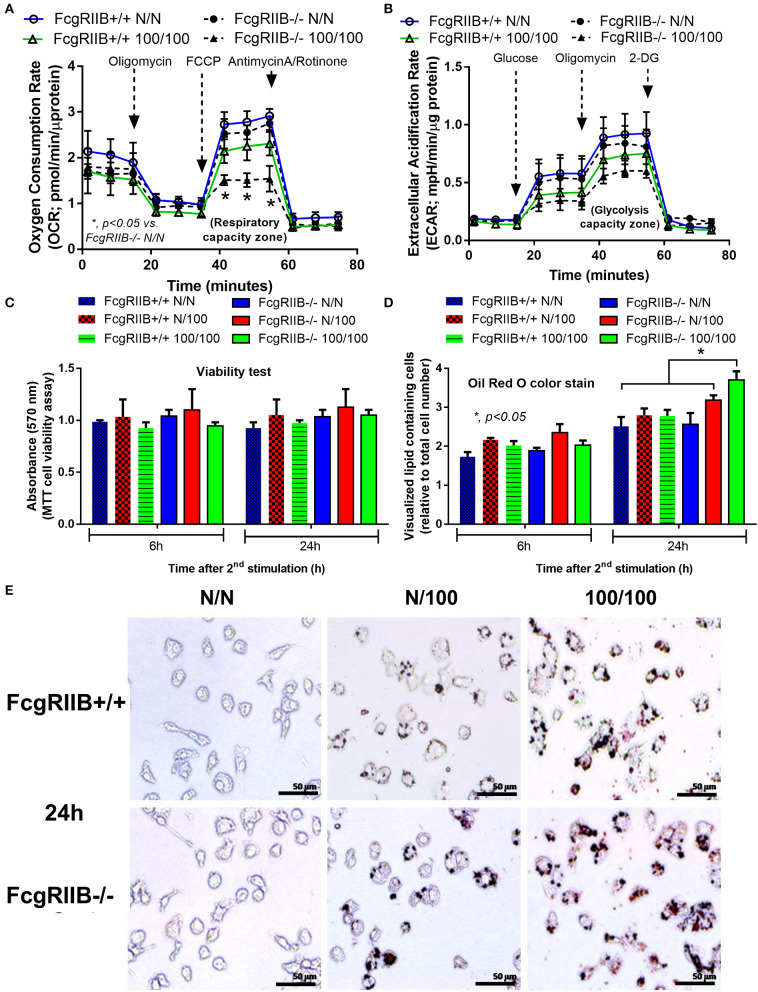
Extracellular flux analysis pattern of macrophages with LPS-tolerance (100/100) or culture media control (N/N) in FcgRIIB–/– and wild-type (FcgRIIB+/+) groups as evaluated by oxygen consumption rate of mitochondrial stress test for mitochondrial pathway analysis (A) and extracellular acidification rate of glucose stress test for glycolysis pathway analysis (B) at 6 h after the second dose of LPS or control culture media are demonstrated. The evaluation on macrophages of wild-type (FcgRIIB+/+) and FcgRIIB–/– cells after the single (N/100) or the sequential (100/100) LPS stimulation vs. control (N/N) in the viability assay analyzed by tetrazolium dye 3-(4, 5-dimethylthiazol-2-yl)-2,5-diphenyltetrazolium (MTT) solution (C), the number of lipid droplets intensity determined by ImageJ software from Oil Red O staining (D), and the representative Oil Red O staining from macrophages in each condition (E) are demonstrated (Independent triplicate experiments were performed for all figures; FCCP, Carbonyl cyanide-4-(trifluoromethoxy)-phenylhydrazone; 2-DG, 2-Deoxy-d-glucose).